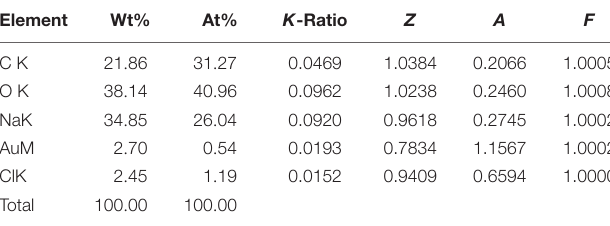
TABLE 3 | Elemental composition of the Au-NPs.